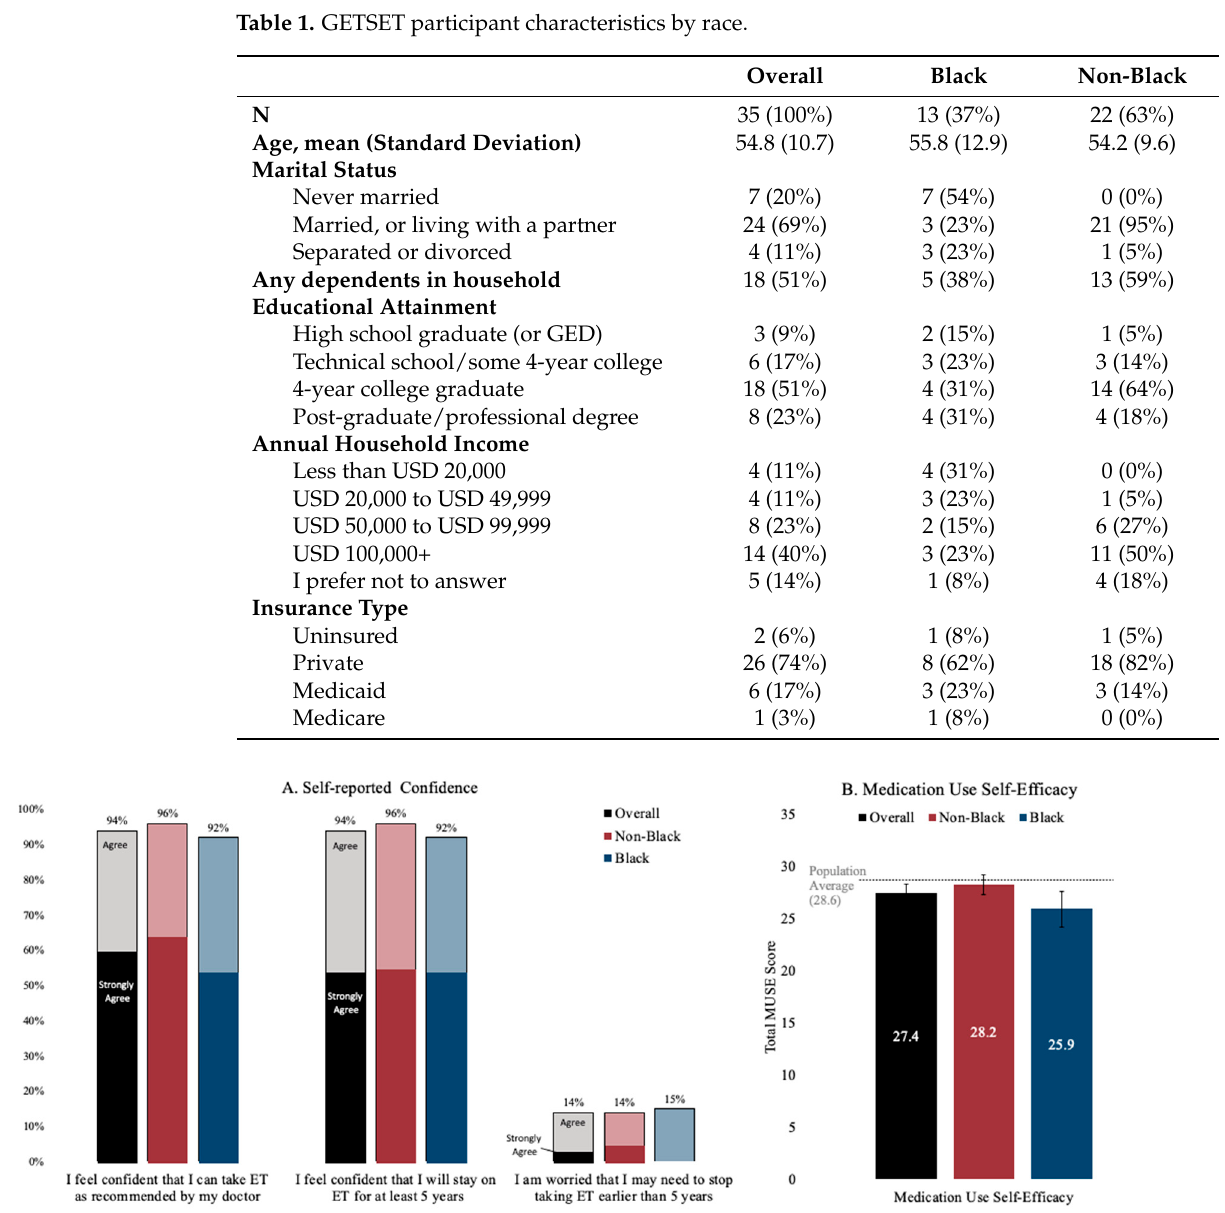
Figure 2. Baseline ET medication-taking confidence (Panel A) and self-efficacy with medication use (Panel B). Notes: Confidence was self-reported using a four-point Likert scale. Medication Use Self- Efficacy (MUSE) is presented as a composite score, with bars representing 95% confidence intervals.